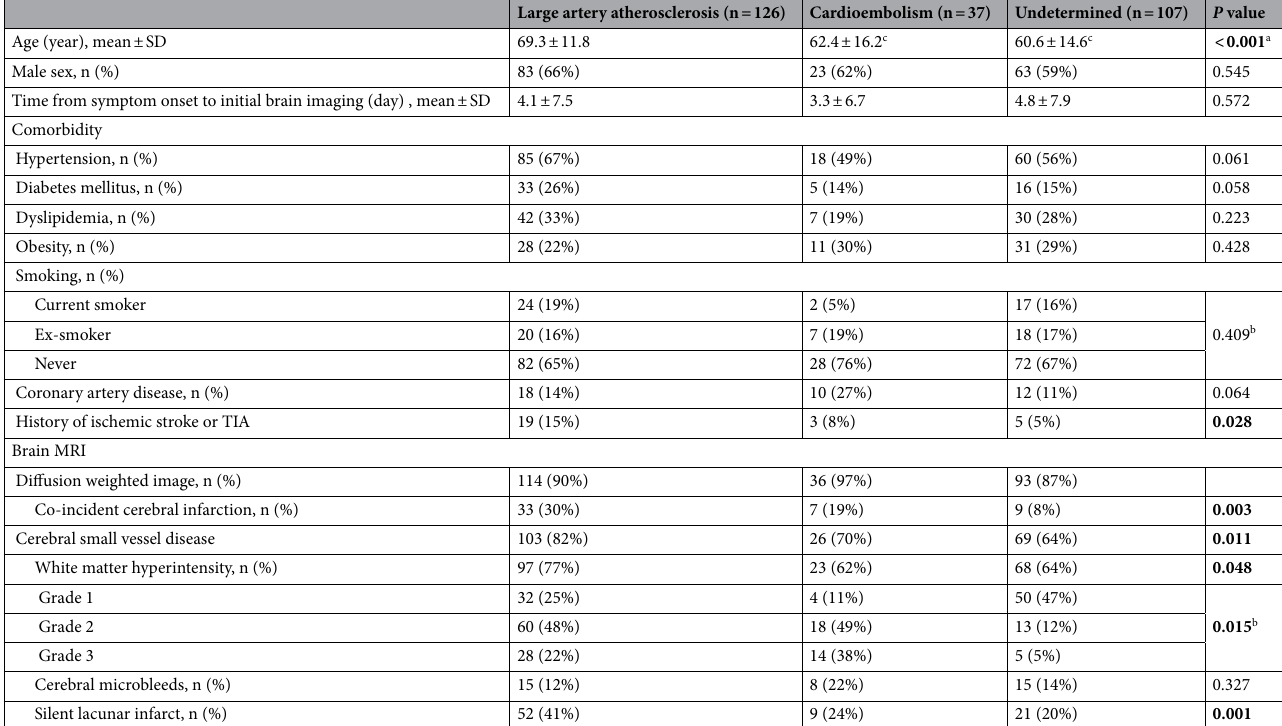
Table 5. Comparison of clinical characteristics and cerebral MRI findings by etiologic subtype between large artery atherosclerosis, cardioembolism, and undetermined in patients with retinal artery occlusion. Data are presented as number (%) or mean ± standard deviation. P < 0.05 was deemed to indicate clinical significance, values in boldface are statistically significant. MRI = magnetic resonance imaging, TIA = transient